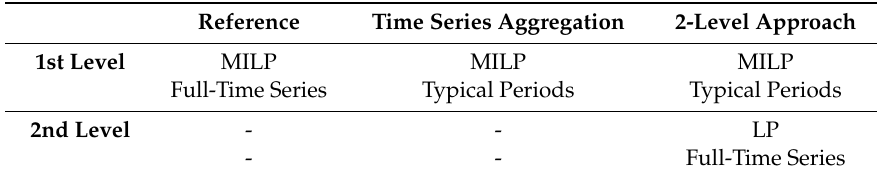
Table 1. Overview of optimization approach and considered time series in 2-Level Approach, time series aggregation and the reference case.